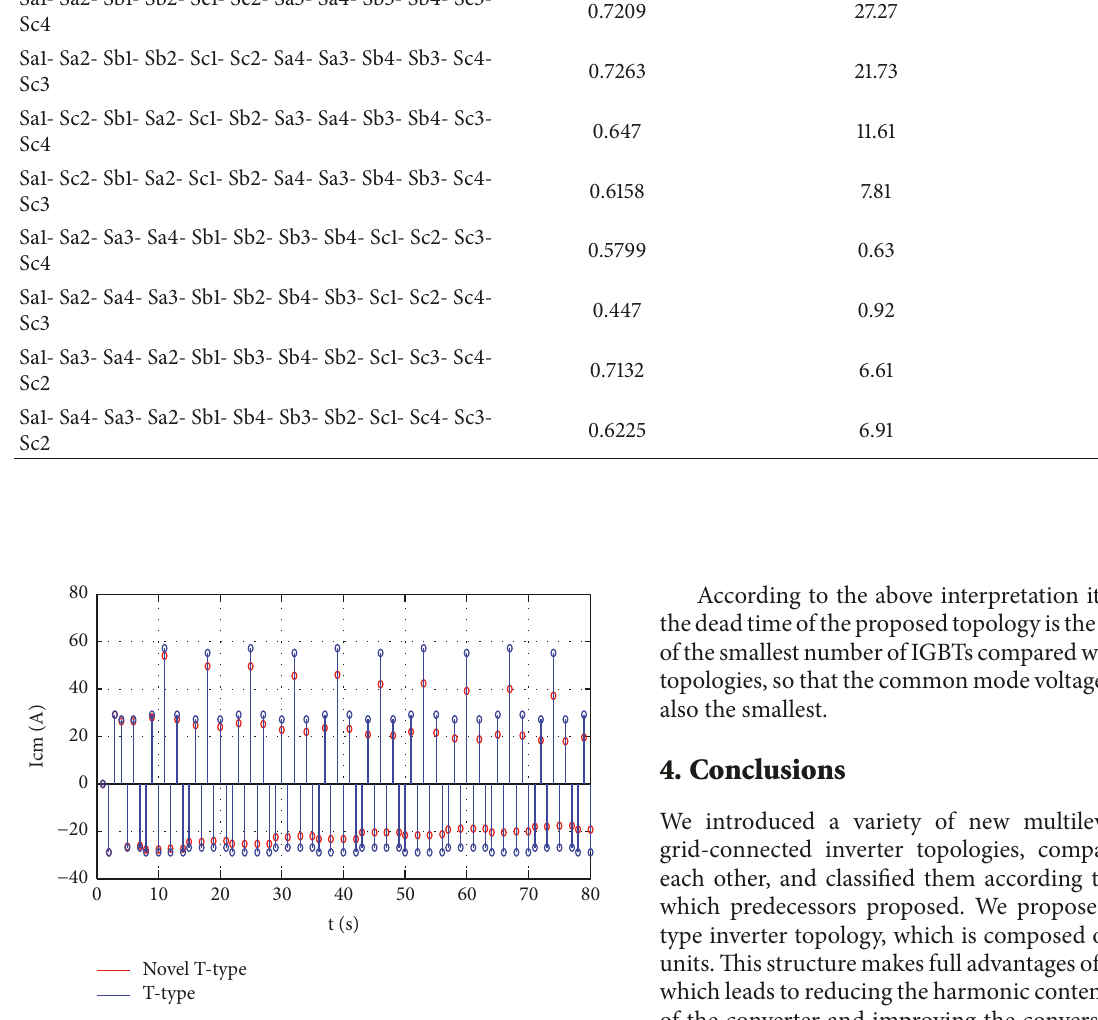
Figure 14: The obtained CM-current of the novel and previous T- type